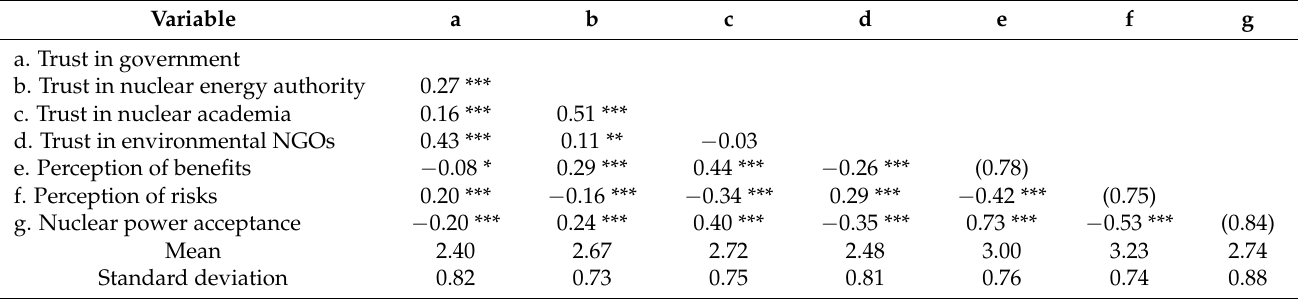
Table 3. Correlations and descriptive statistics of key